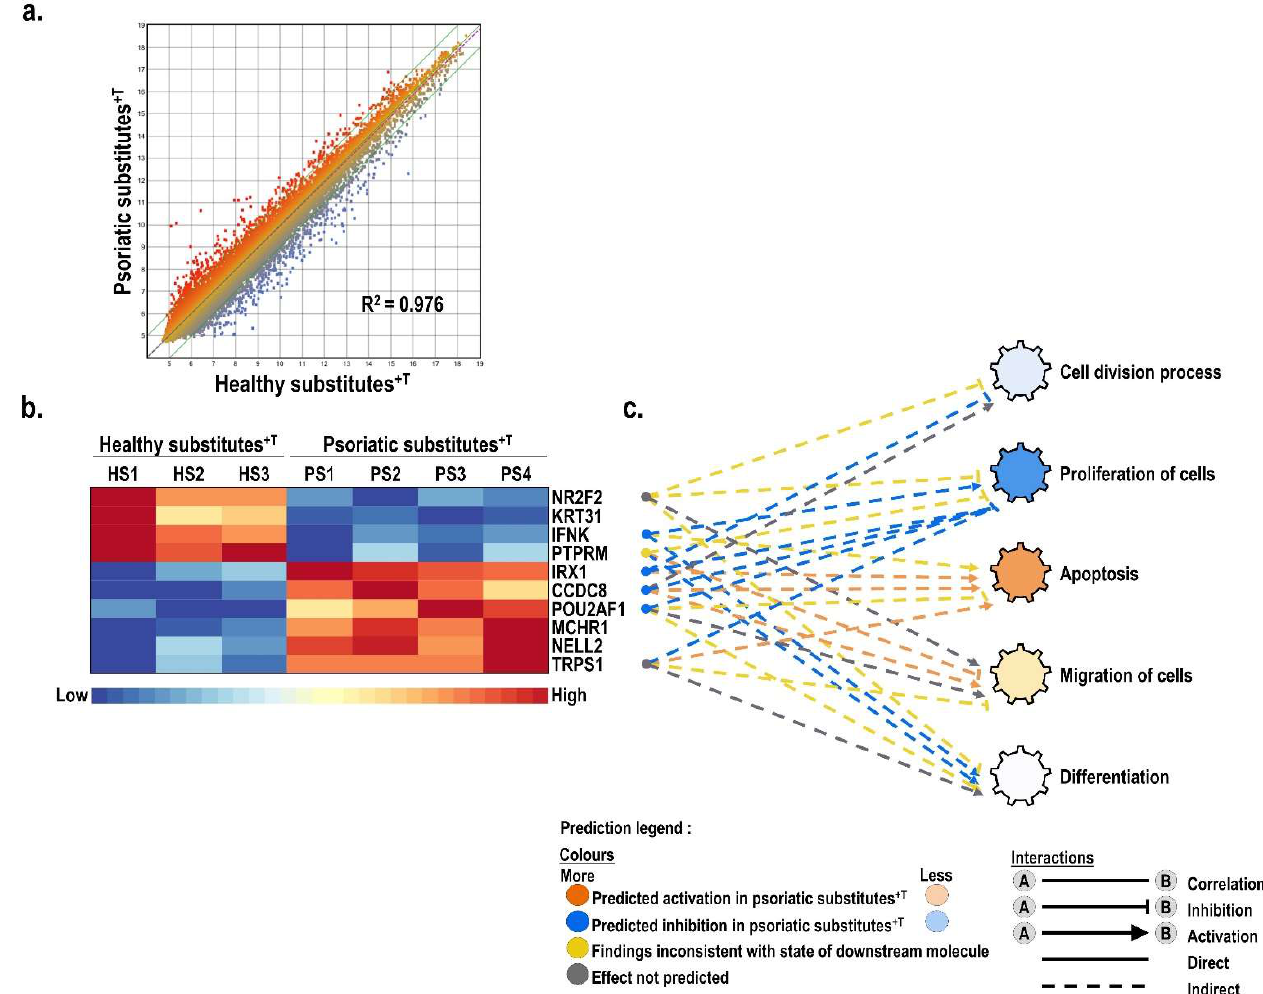
Figure 2. Microarray analysis of the gene expression pattern between T cell-enriched healthy and psoriatic skin substitutes. ( a ) Scatter plots of log2 of signal intensity from 60,000 different probes covering the entire human transcriptome of HS +T ( x -axis) against PS +T ( y -axis). The color scale corresponds to the level of gene expression (dark blue being the lowest and dark red the highest) ( b ) Heatmap representation of the expression profile for the 10 genes identified through the IPA analysis as the most strongly deregulated between healthy ( n = 3) and psoriatic ( n = 4) skin substitutes enriched with T cells. ( c ) Ingenuity pathway analysis of gene interaction networks altered in PS +T condition built around biological functions of interest: proliferation, differentiation, migration, apoptosis and cell division. HS +T , healthy skin substitutes with T cells; PS +T , psoriatic skin substitutes with T cells.